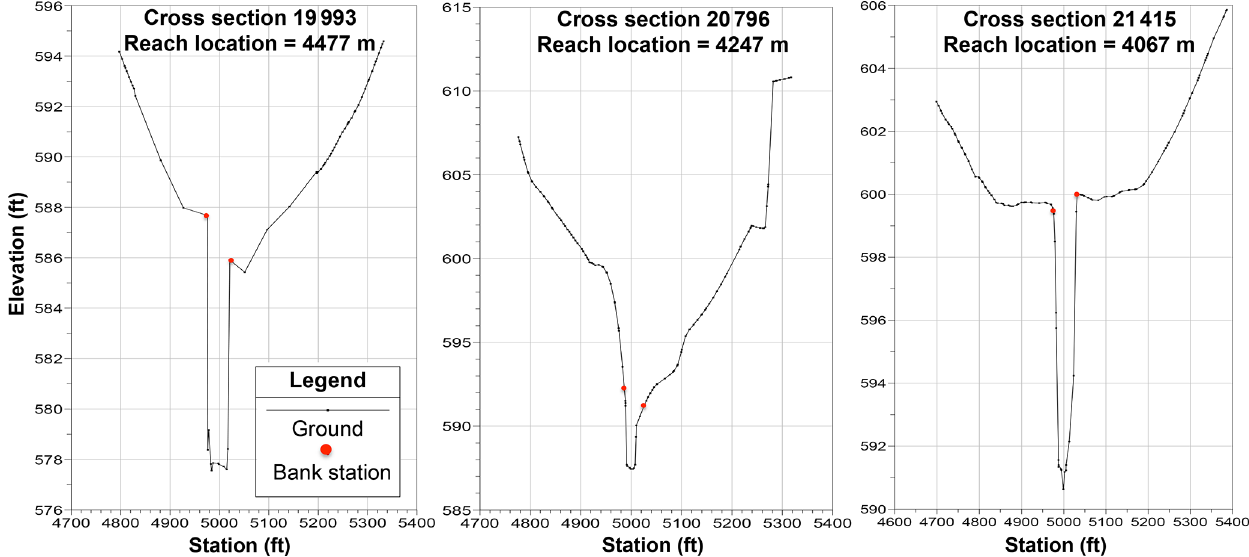
Figure A1. Cross sections removed from Waller Creek data set to provide numerical stability of unsteady HEC-RAS.